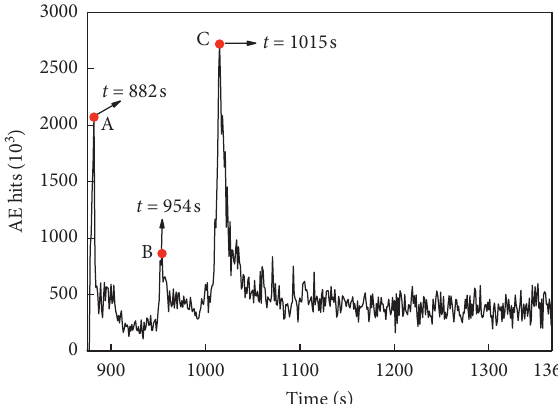
Figure 11: The curve of AE hits evolution after unloading under confining stress of